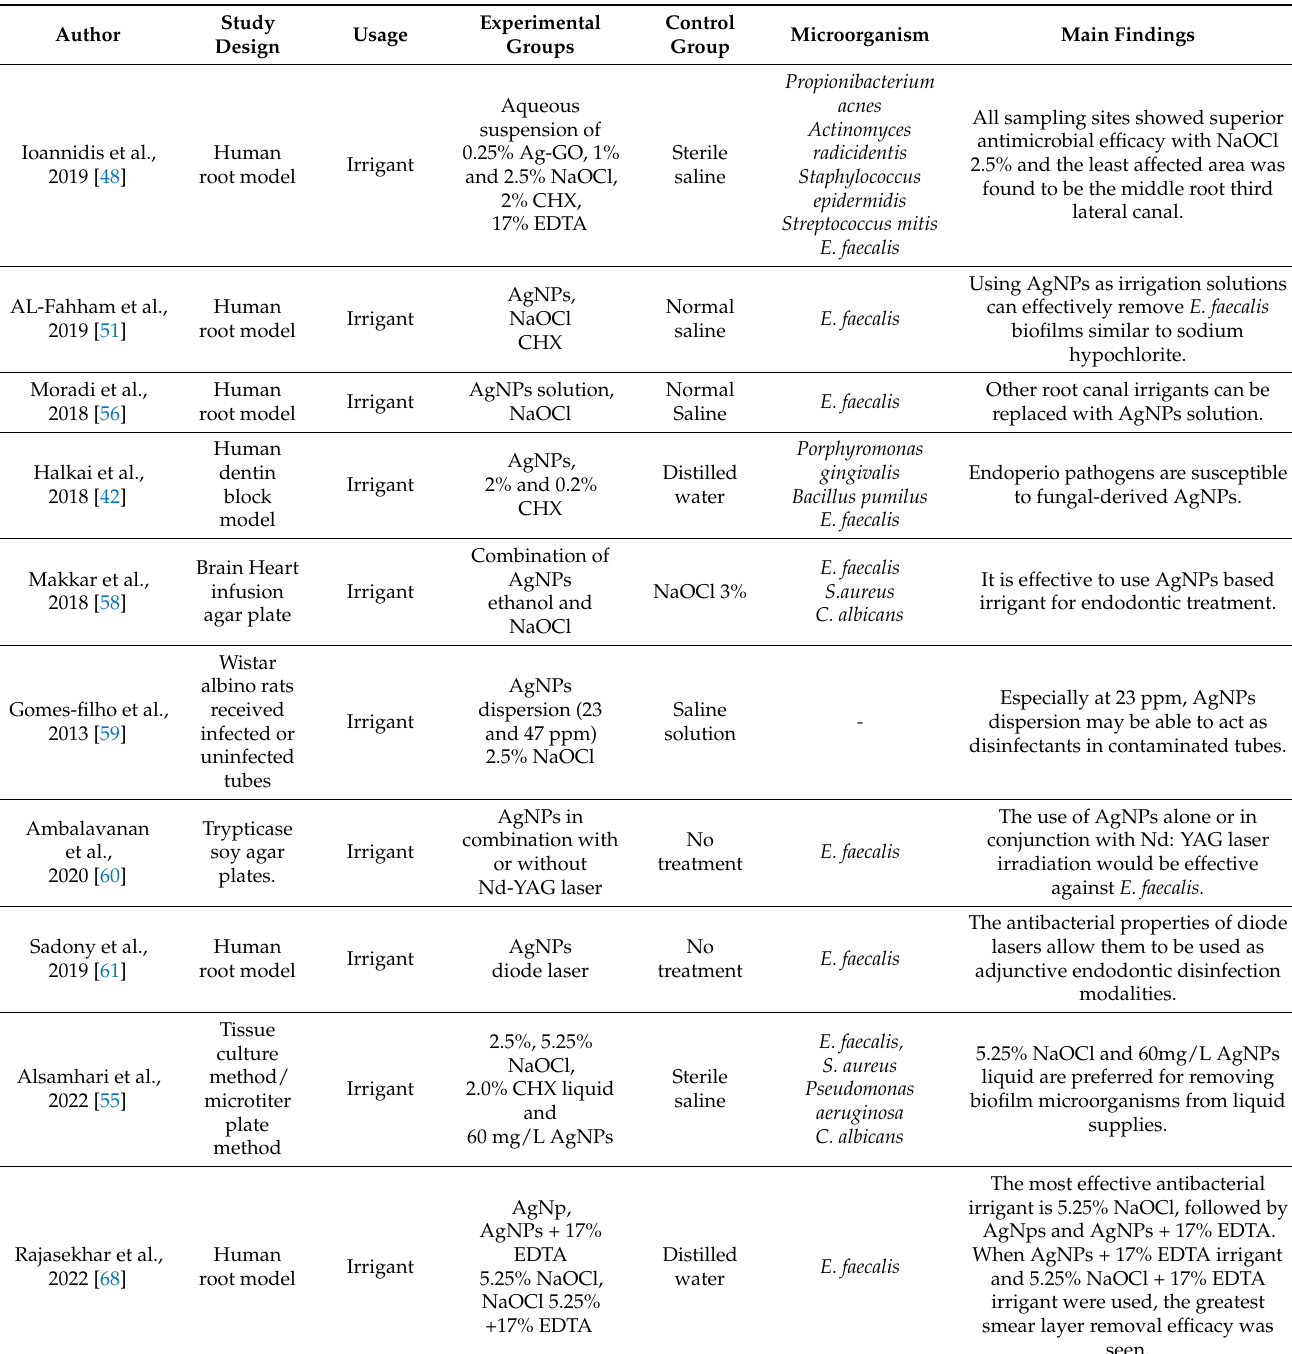
Table 2. Studies of alternative antimicrobial irrigants highlighting antimicrobial type, study design, usage, experimental and control groups, microorganisms tested, and main